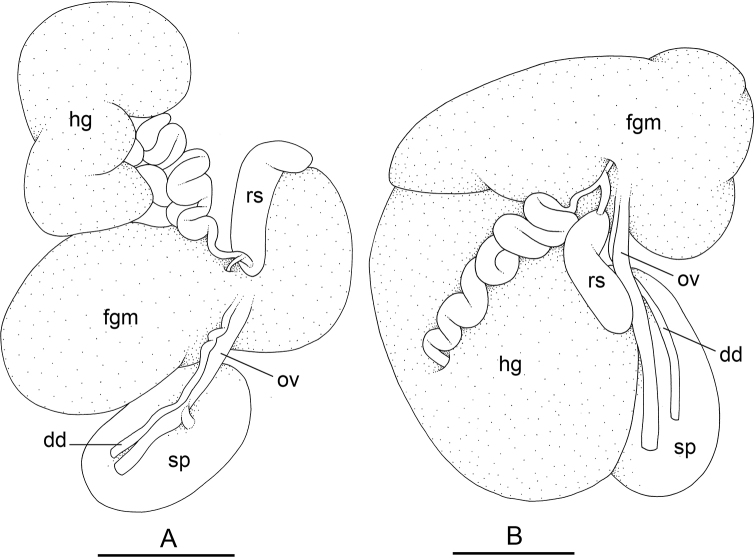
Posterior, hermaphroditic (female) reproductive system, Peronia
peroniiA Mauritius [3605] (MNHN-IM-2019-1606) B Papua New Guinea, Madang [5472] (MNHN-IM-2013-14052). Scale bars: 10 mm (A), 5 mm (B). Abbreviations: dd deferent duct, fgm female gland mass, hg hermaphroditic gland, ov oviduct, rs receptaculum seminis, sp spermatheca.